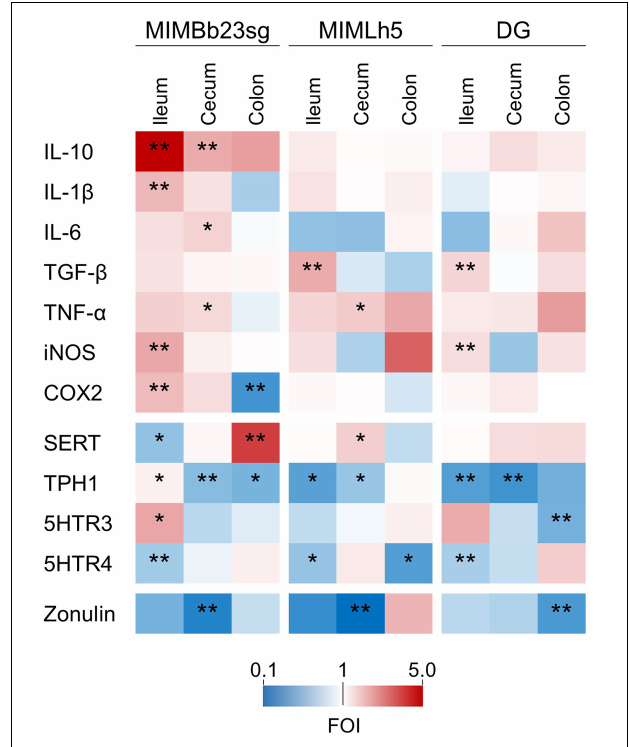
FIGURE 4 | Heatmaps summarizing the results of gene expression analysis performed by RT-qPCR to identify genes whose expression was significantly modulated by the treatment with probiotic strains compared to the control condition (gavage with PBS). The fold of induction (FOI) for each gene is displayed as color ranging from blue to red as shown in the key. Asterisks indicate statistically significant differences according to Mann-Whitney U -test; ** P < 0.01; * P <